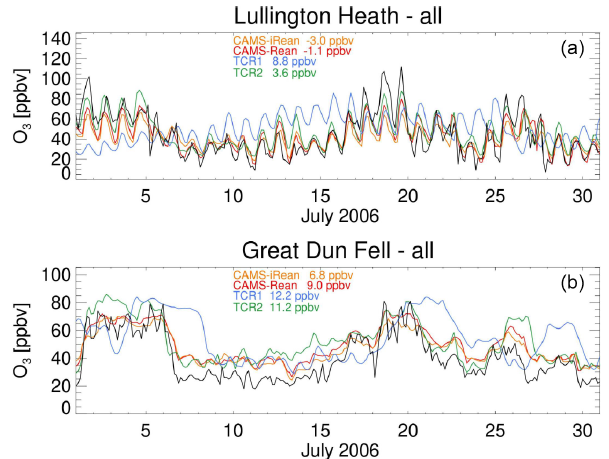
Figure 10. Time series of reanalyses against ozone observations at two EMEP stations in Great Britain during July 2006: Lulling- ton Heath ( a , 120ma . s . l . , model levels 3 (CAMS) and 1 (TCR)) and Great Dun Fell ( b , 847ma . s . l . , model levels 8 (CAMS) and 3 (TCR)). Also given are mean